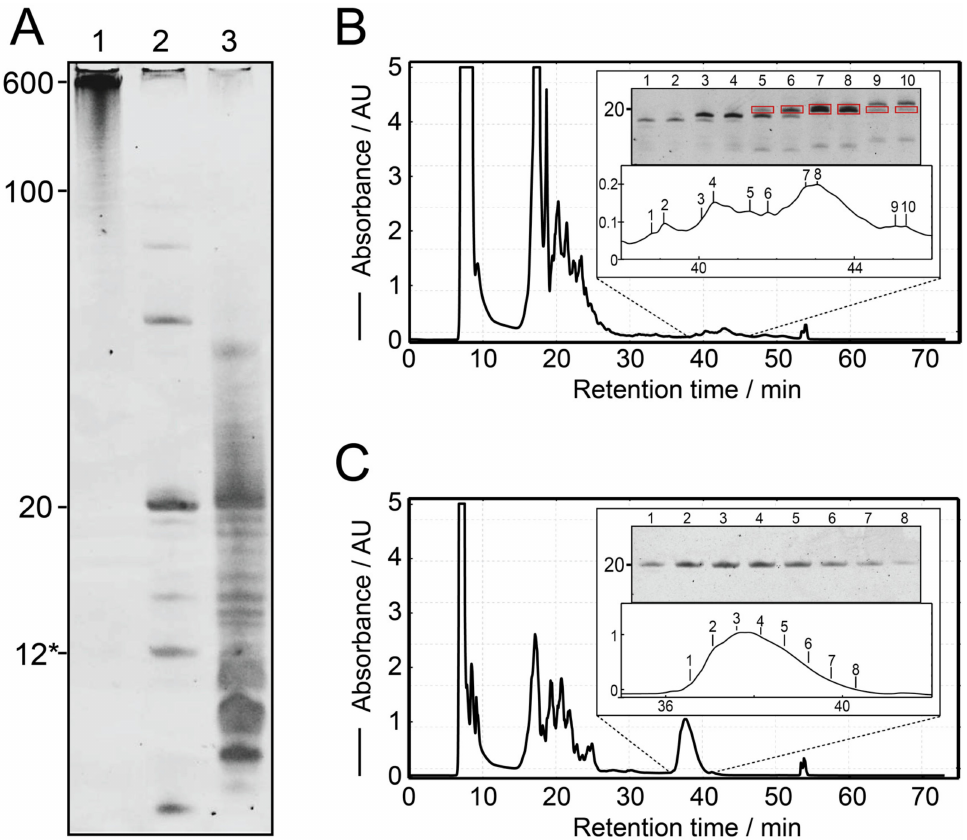
Figure 2. Proof of principle on construct 1. ( A ): Denaturing polyacrylamide gel showing the cleavage of a tandem transcript and comparison of transcription from a single-repeat ssDNA template.